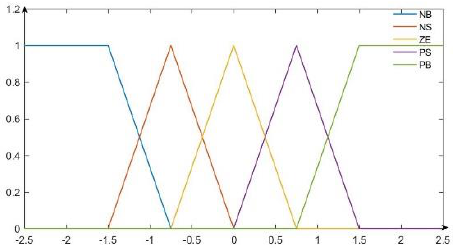
e k and i e k and i